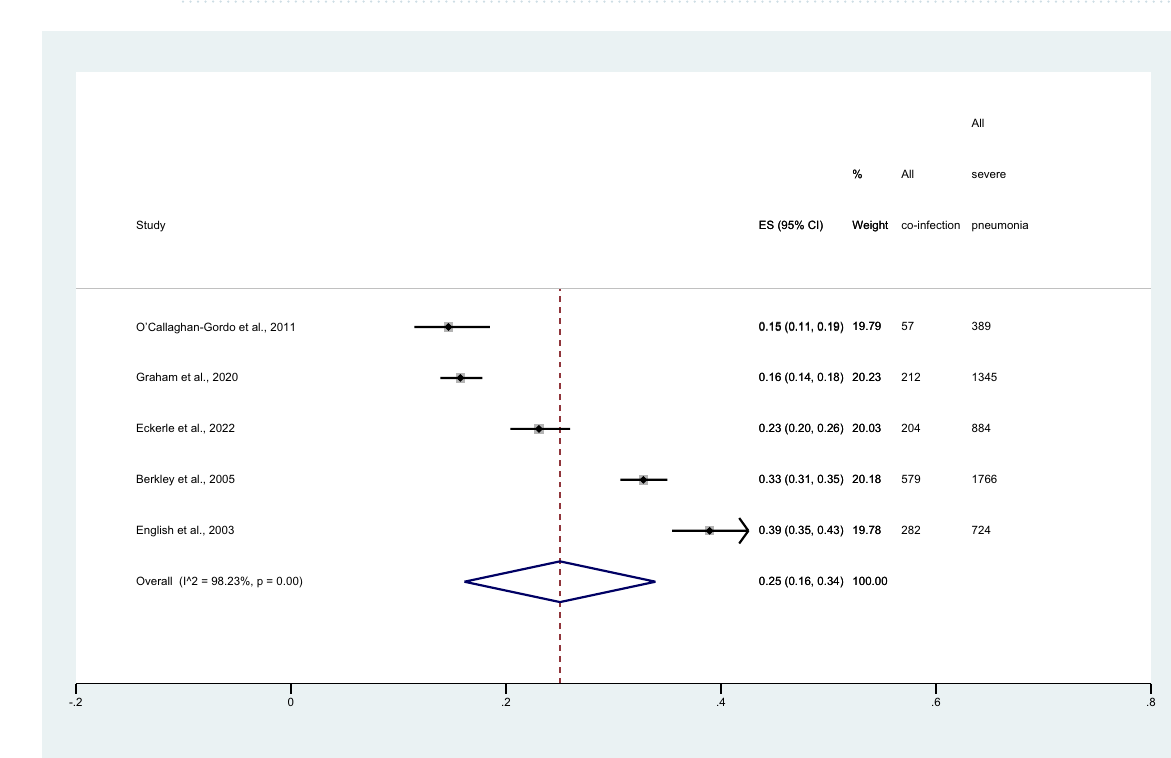
Figure 7. Forest plot demonstrates the pooled proportion of malaria among patients with severe pneumonia in studies that used chest X-ray to confirm the severe pneumonia. ES, proportion estimate; CI, confidence interval.